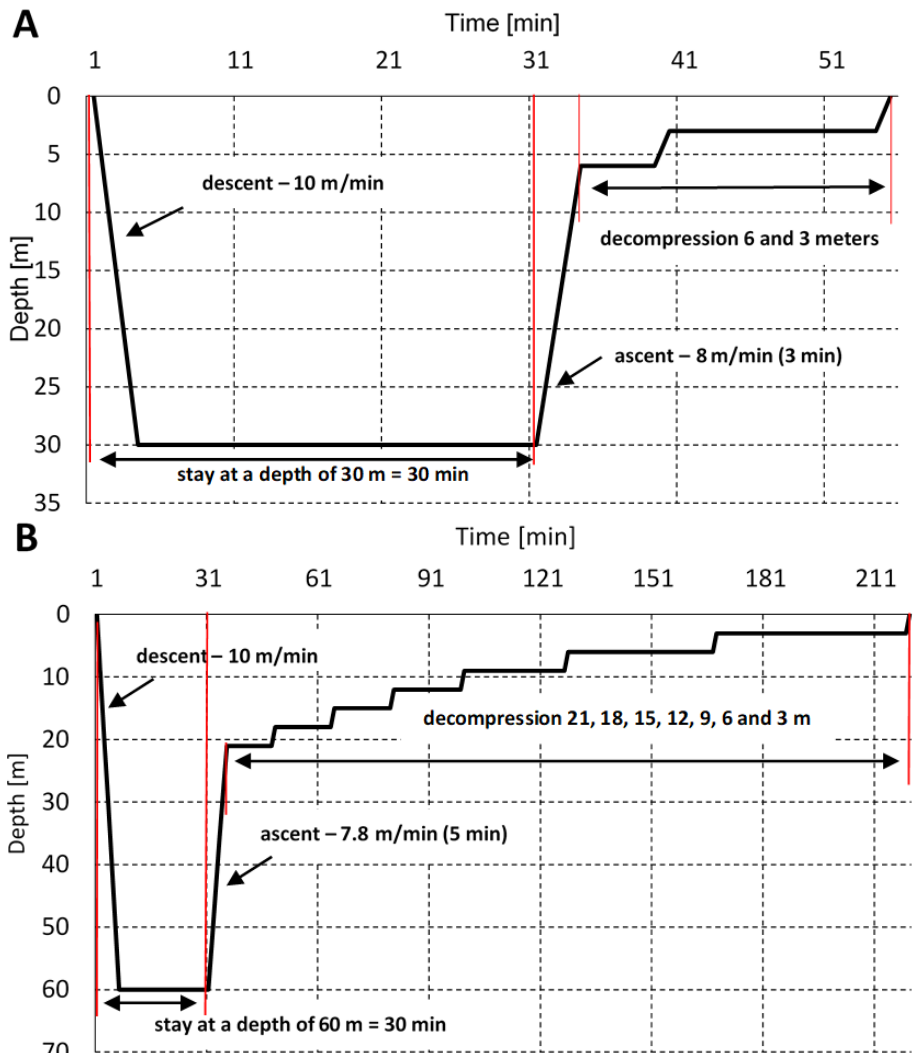
Figure 1. The dive profiles—30 m ( A ) and 60 m ( B ). The time of stay at depths of 30 and 60 m, including the time of the descent. Decompression stations are marked.